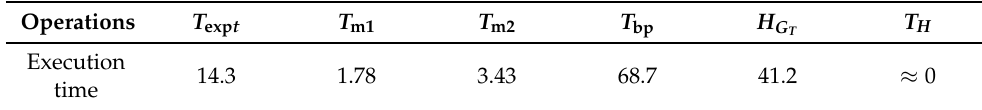
Table 2. Time consumption of basic operations (ms).